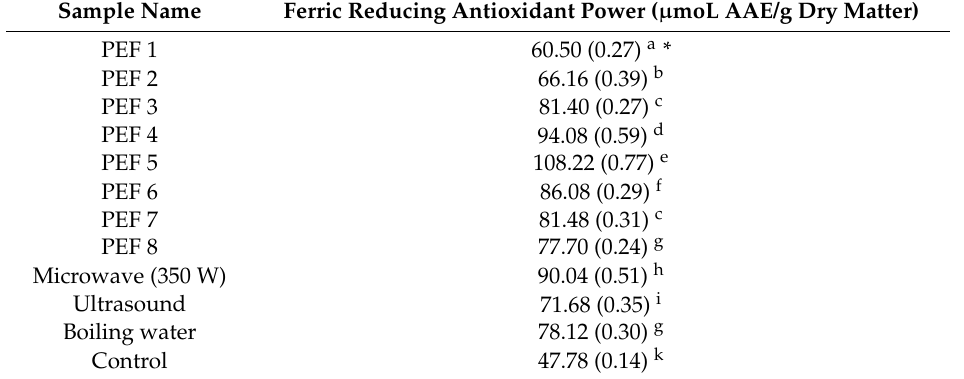
Table 4. Antioxidant activity (ferric reducing antioxidant power—FRAP assay) of the